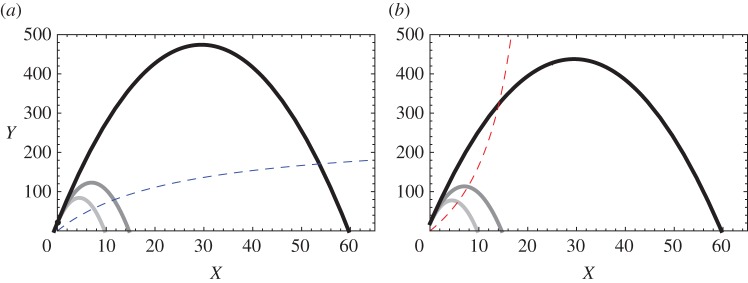
Phase-plane diagrams. Hump shaped solid lines are prey isoclines with different carrying capacities (light grey: K=10, grey: K=15, black: K=60). Dashed lines are predator isoclines, when (a) the finder’s advantage is small (f/F≤dh/b) and (b) the finder’s advantage is large (f/F>dh/b). The intersections of the isoclines are coexistence equilibria. The predator isocline is the same for all carrying capacity levels. Parameters were set to the following values: r=15, a=1, b=0.5, h=1, d=0.25, F=1, g=5, f=0.48 for (a) and f=0.52 for (b).